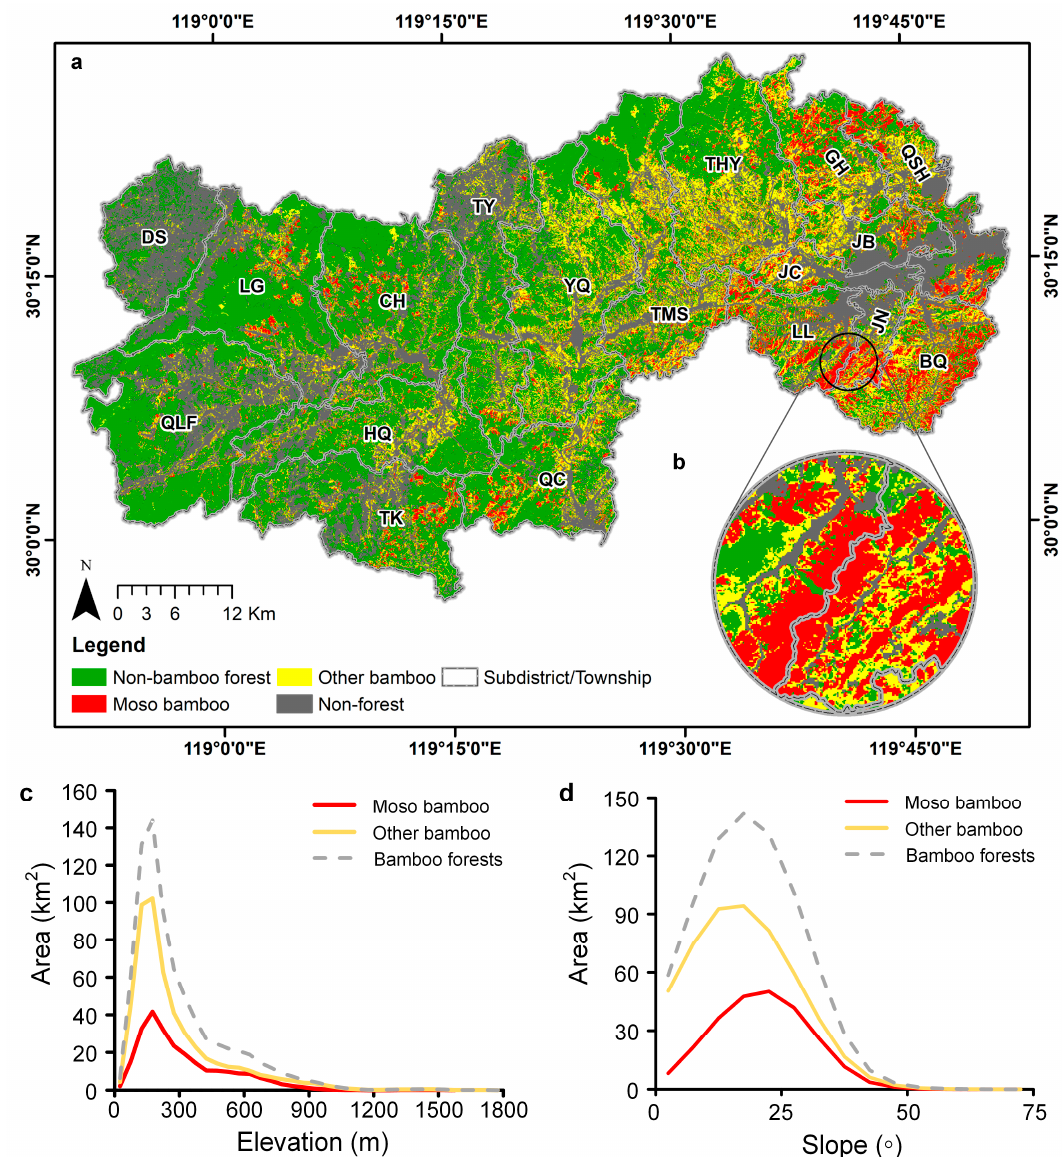
Figure 4. ( a ) The bamboo forest map for the late 2010s. ( b ) A zoom-in view of one representative bamboo forest region, indicated by the circle in Figure 4a. ( c ) and ( d ) show the area distribution of bamboo forests in the late 2010s along elevation and slope gradients, respectively.